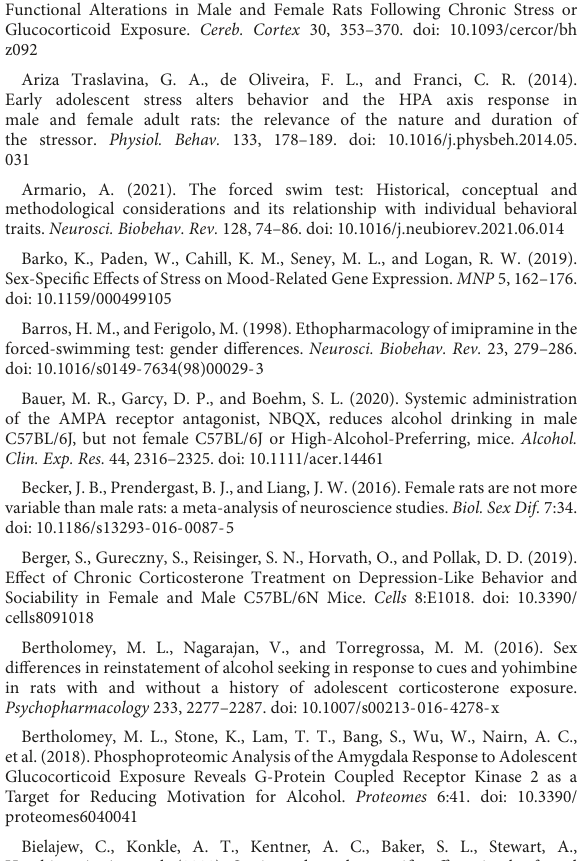
SUPPLEMENTARYFIGURES1 Uncropped blots from which representative bands in Figure 7 are derived. Samples with boxes around the labels in the gel map and arrows pointing to the bands correspond to the cropped images in Figure 7 for adolescent BLA expression of GluA1 (a) , GluA2/3 (b) , and GAPDH (c)